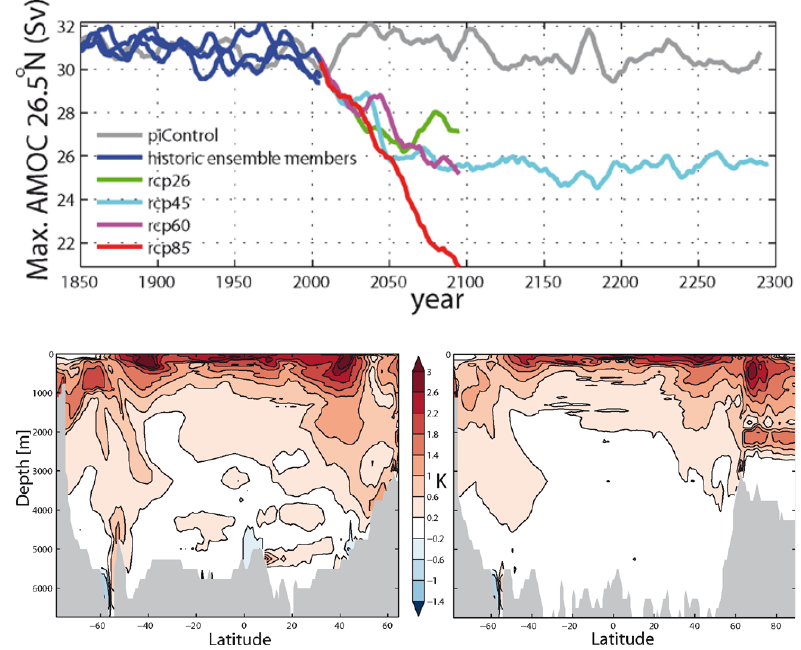
Fig. 10. The top panel shows decadal moving averages of the annual max AMOC at 26.5 ◦ N, where grey is piControl, blue are Historic1, 2, and 3, green is RCP2.6, turquoise RCP4.5, violet RCP6.0, and red is RCP8.5. The bottom two panels show annual and zonal mean NorESM1-M simulated ocean temperature change for years 2071–2100 with RCP8.5 compared to piControl. Left: the Atlantic Ocean, right: global oceans.